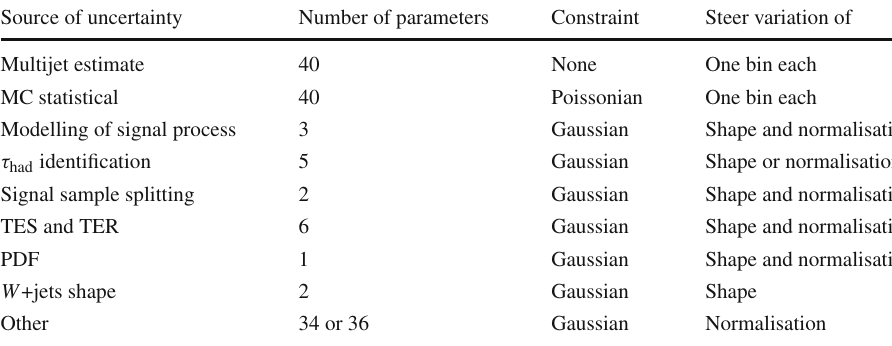
Source of uncertainty Number of parameters Constraint Multijet estimate Modelling of signal process